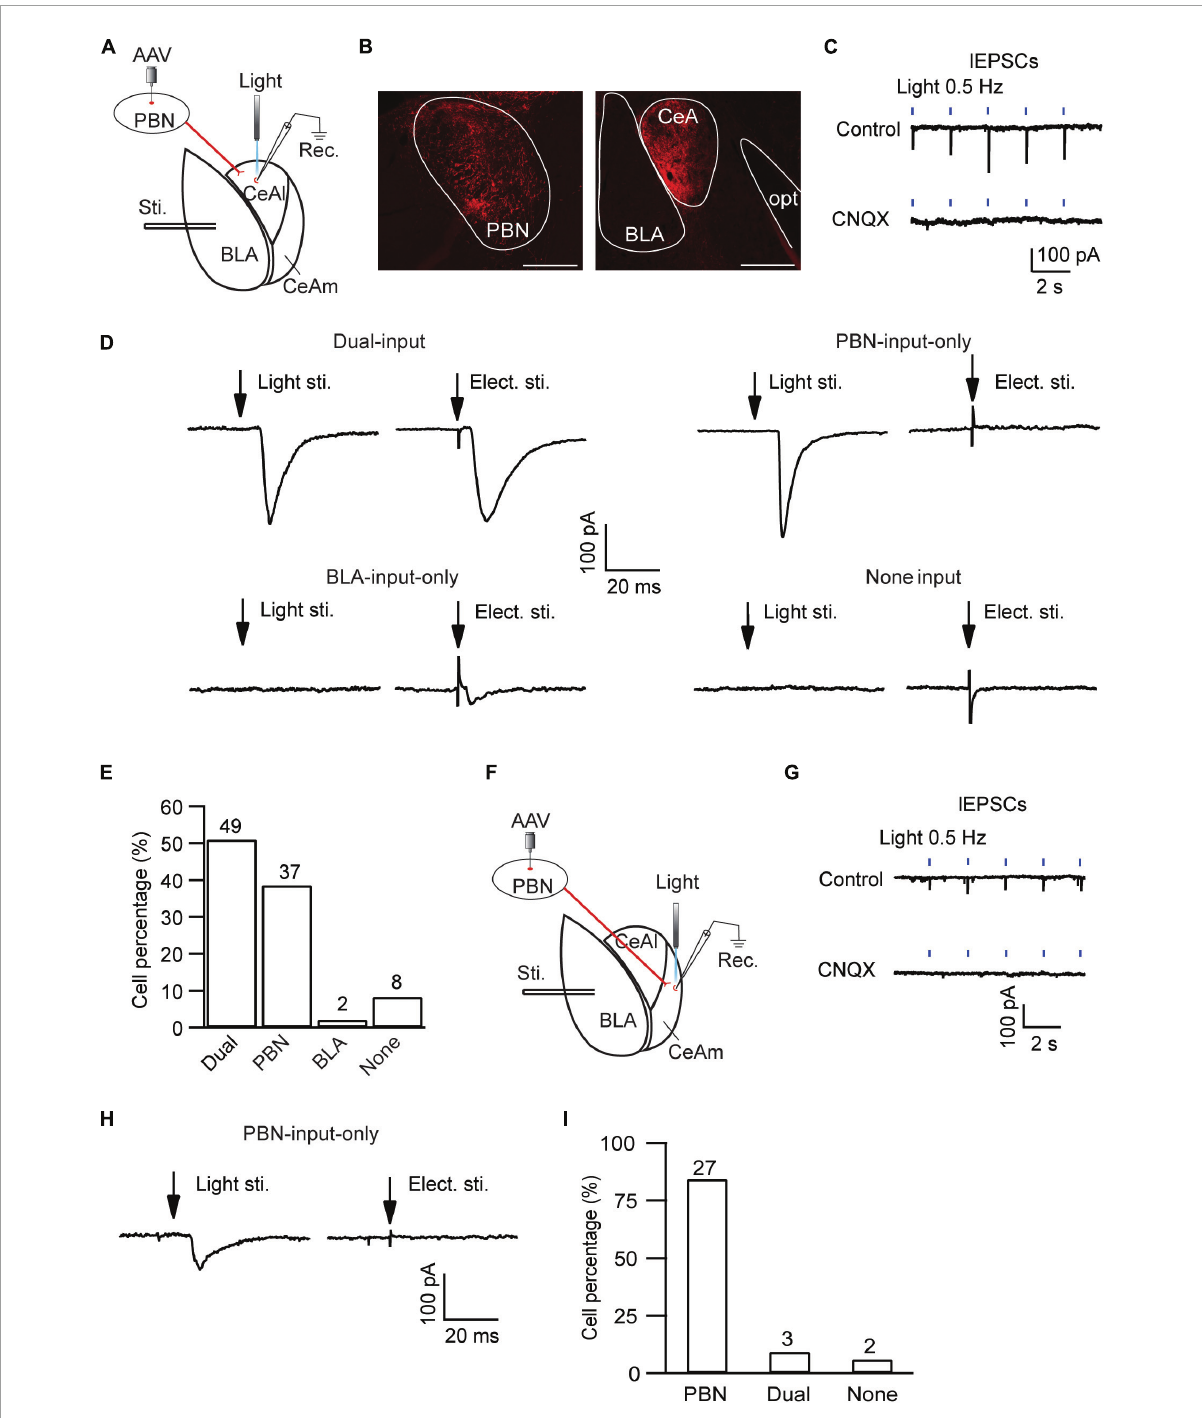
FIGURE4 Distinct, input-specific types of cells in CeAl and CeAm from naïve rats. (A) A schematic of experimental settings for cell types in CeAl, with the adeno-associated viral (AAV) vector, AAV-CaMKII-hChR2-mCherry, injected in the PBN and 4 weeks later, electrical stimulation in BLA, and light (optical) stimulation and whole-cell recording in CeAl. (B) Images of fluorescence staining in transfected cells in PBN (Left) and projection terminals in amygdala (Right). Scale bars = 500 µ m. opt, optic tract. (C) Sample traces of light-evoked EPSCs (lEPSCs) by 473 nm light at 0.5 Hz in CeAl neurons before (control) and after application of CNQX (10 µ M), n = 4. (D) Representative EPSC traces in CeAl cells that display (1) both PBN-elicited lEPSC and BLA-elicited eEPSC (dual-input), (2) lEPSC only (PBN-input only), (3) eEPSC only (BLA-input only), and (4) no EPSC (none input). eEPSCs were evoked by 600 µ A. (E) Number and percentage of each cell type in the population of CeAl cells recorded. (F) A schematic of experimental settings similar to A, but with light stimulation and whole-cell recording in CeAm. (G) Traces of lEPSCs in CeAm neurons before (control) and after application of CNQX (10 µ M), n = 4, with the same light stimulation as in C. (H) Current traces in a CeAm cell with lEPSC only (PBN-input only). (I) Percentage of three cell types found in CeAm. The numbers on top of each column indicate the cell number in each group of the cell